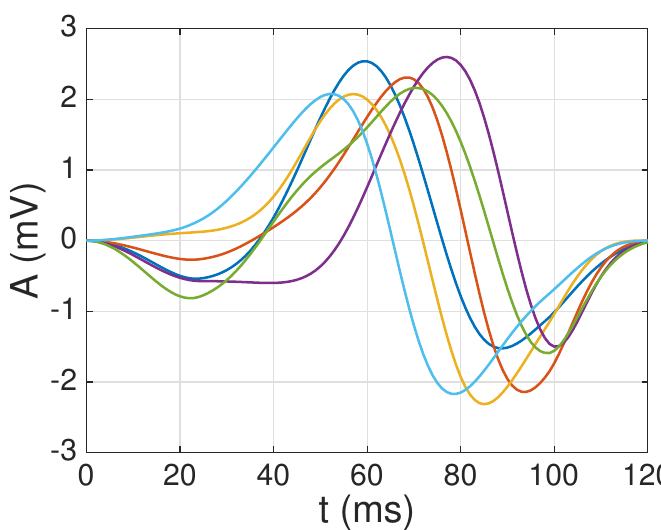
Figure 7. K = 6 atoms selected from the Q (cid:48) = 44 reliable average QRS complexes obtained from the Q = 51 healthy patients in the PTB database, using a threshold γ = 0.9.